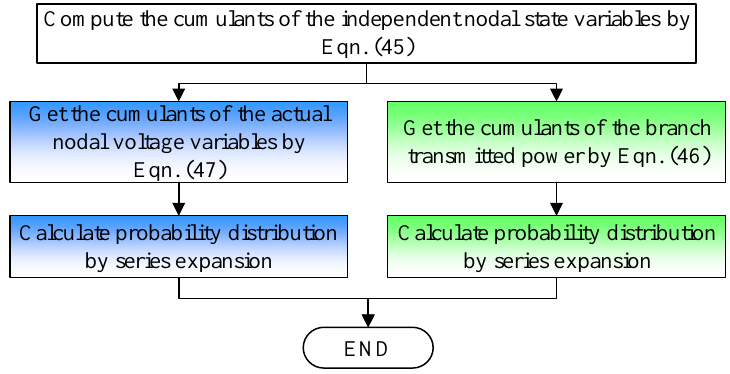
Figure 3. Flowchart of the improved PLF algorithm based on parallel computing.